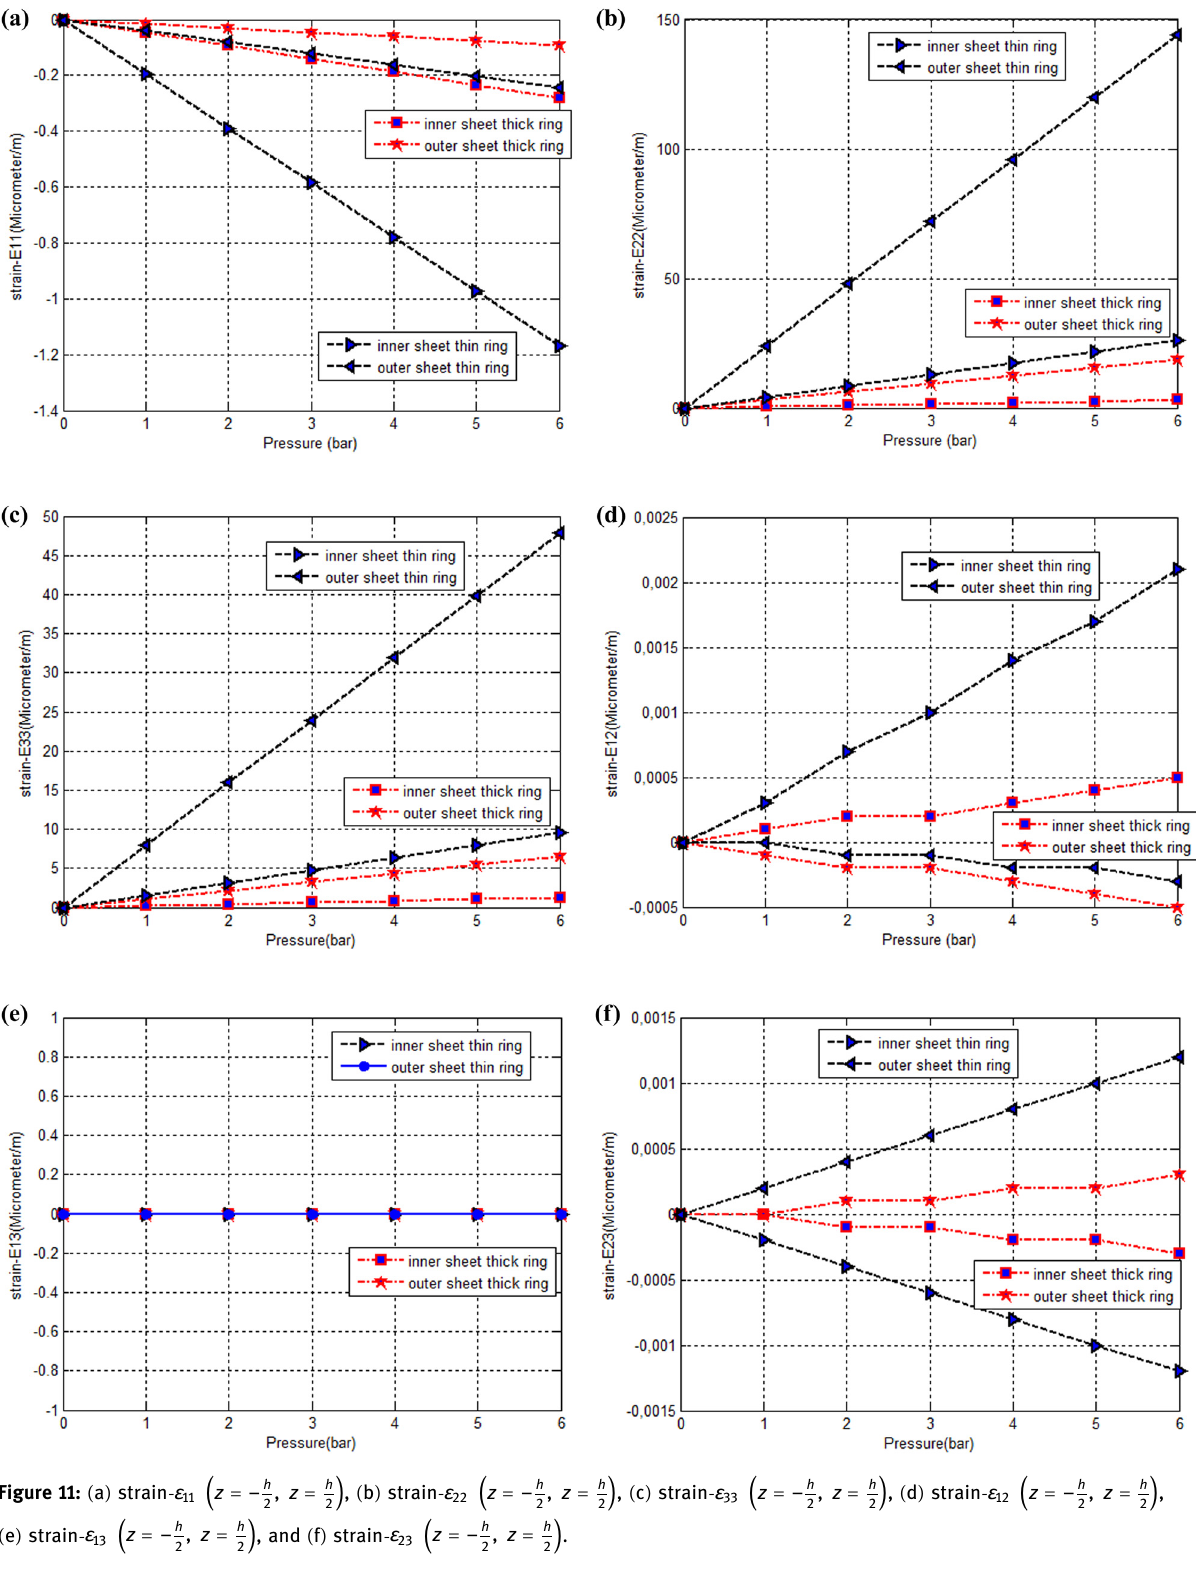
Figure 11: ( a ) strain -